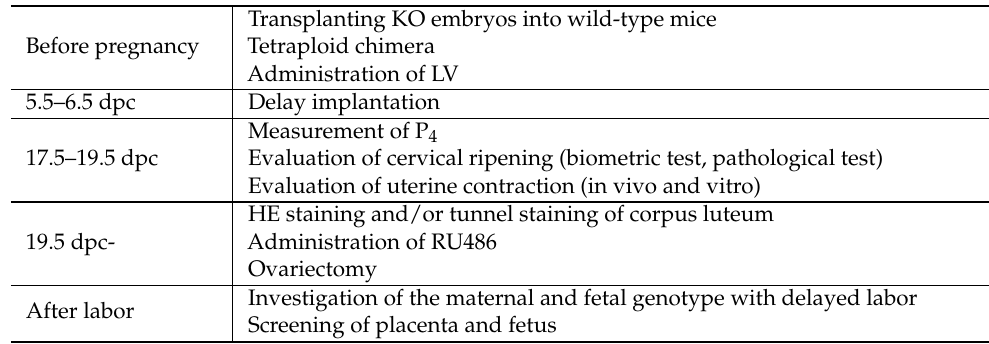
Table 2. List for finding the cause of delayed delivery. If genetically modified mice exhibit delayed labor, we recommend investigating the